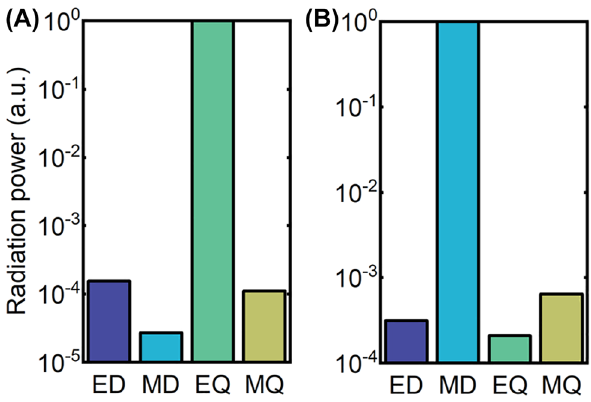
Figure 2: Multipolar contents of (A) quasi-BIC I and (B) quasi-BIC II for Δ y = 50 nm. The vertical axis shows normalized radiation powers of electric and magnetic dipole (ED and MD) moments, and electric and magnetic quadrupole (EQ and MQ)